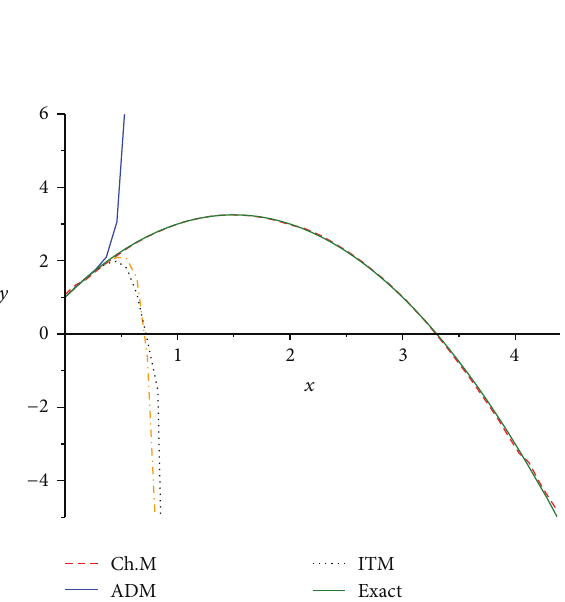
Figure 4: Numerical solutions of Example 2, for some values of 𝑚 .